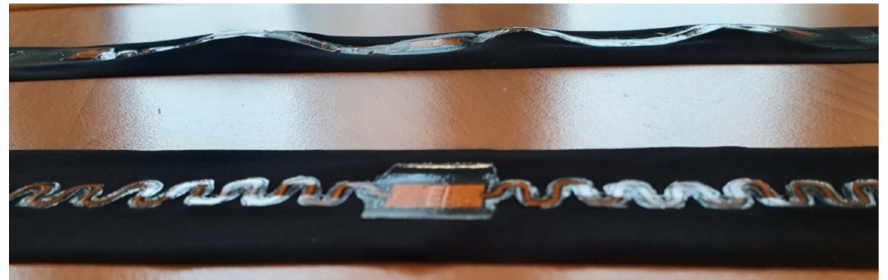
Figure 7. Elasticity difference of V1 and V4 samples. Up: V4 sample after 100 tensile test cycles. The laminated circuit is distorted together with the fabric. Down: V1 sample after 100 tensile test cycles. No distortions into the lamianated circuit or fabric were seen.